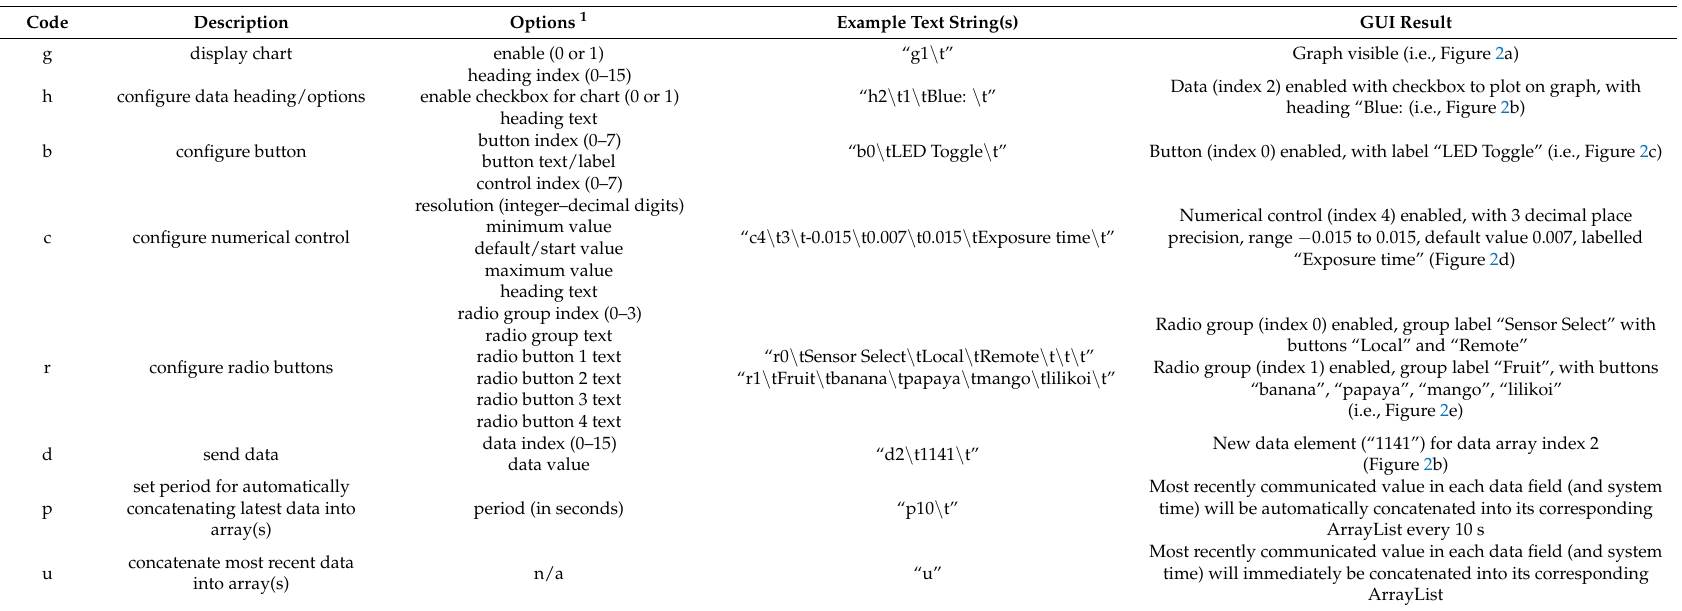
Table 2. Coded instructions from remote device to populate ABE-VIEW interface, and share